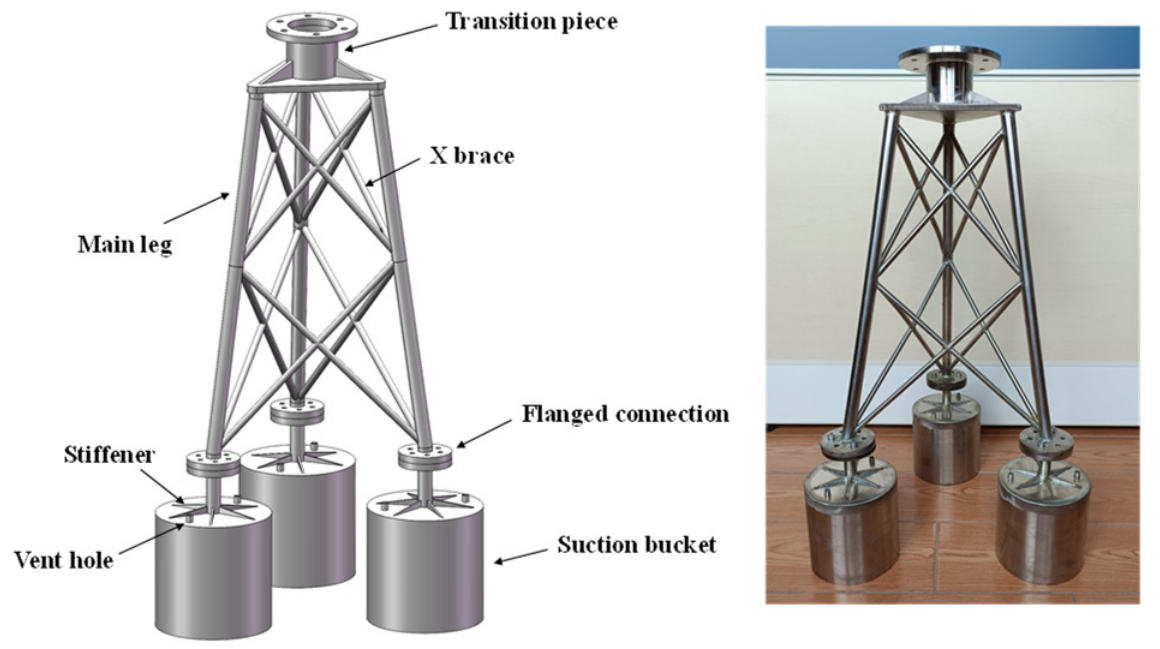
Figure 2. Model tripod bucket jacket structure.